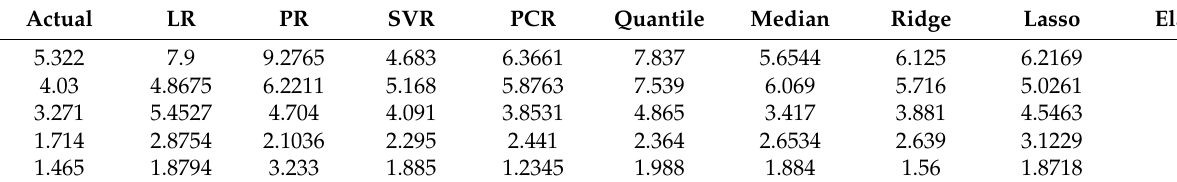
Table 4. Predicted TL values using the regression models in turning.